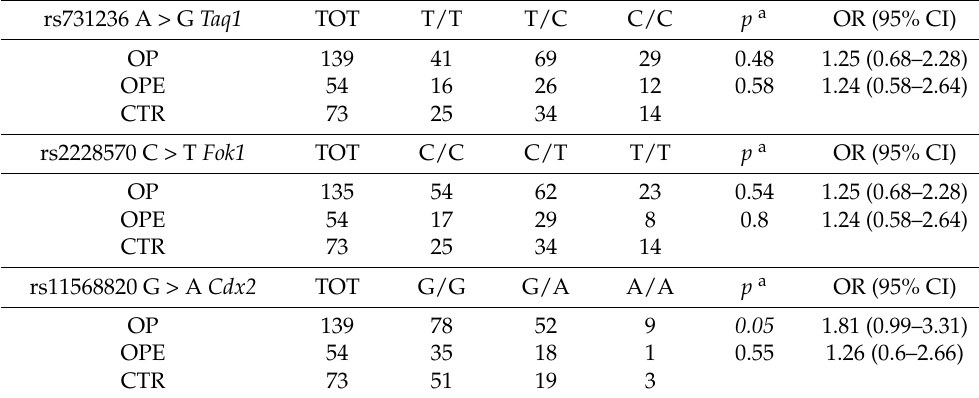
Table 2. Genotype distribution of VDR